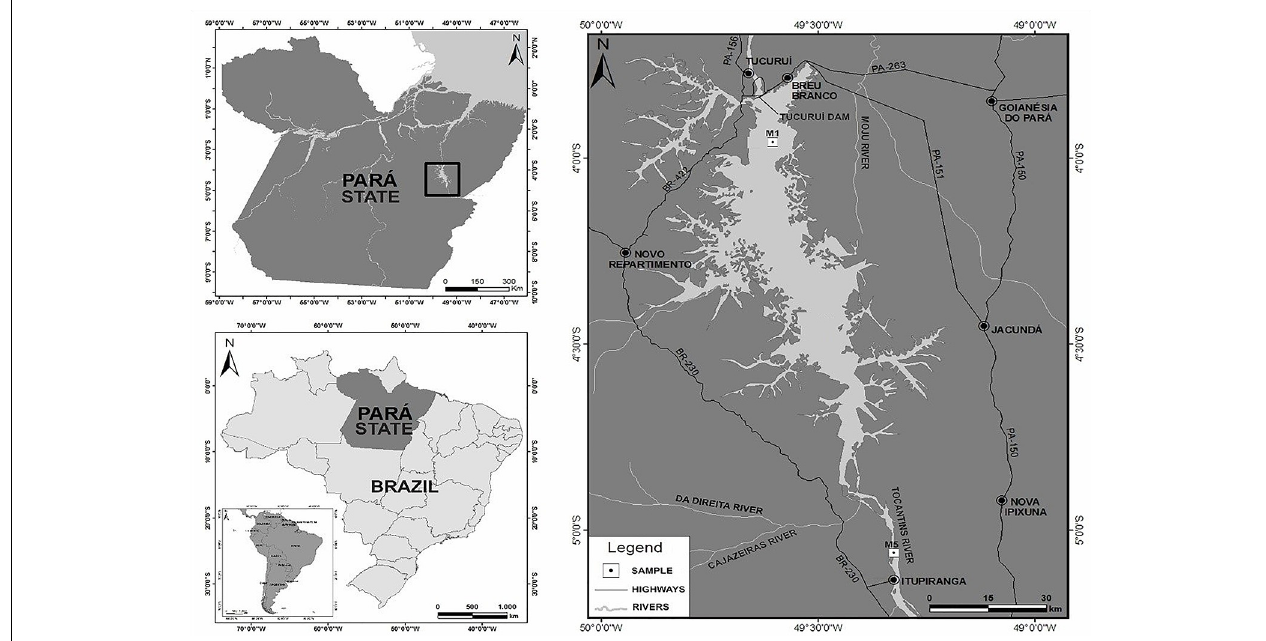
FIGURE 1 | Map of Tucuruí Hydroelectric Dam, showing the M1 sampling